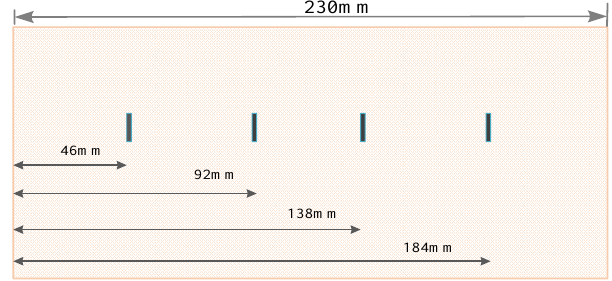
Figure 11. The distribution of damage at different locations .